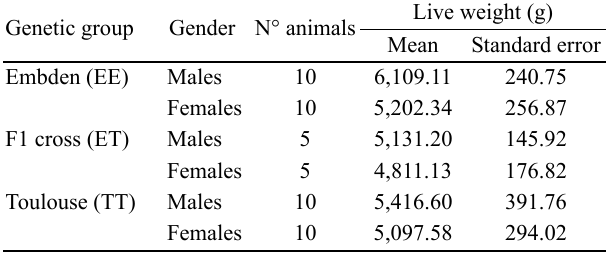
Table 2. Description of sampled geese raised in the dehesa system and live weight (mean±standard error) per genotype